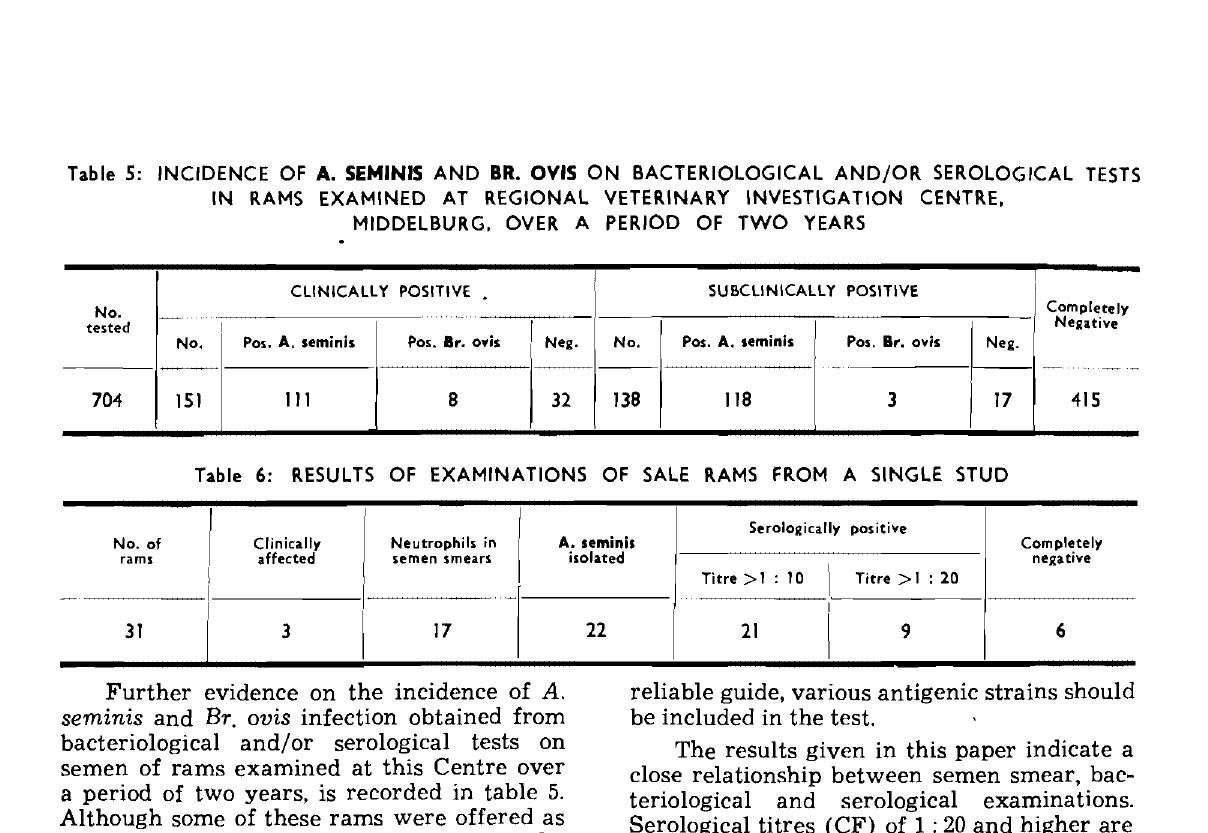
Table 5: INCIDENCE OF A. SEMINIS AND BR. OVIS ON BACTERIOLOGICAL AND/OR SEROLOGICAL TESTS IN RAMS EXAMINED AT REGIONAL VETERINARY INVESTIGATION CENTRE, MIDDELBURG, OVER A PERIOD OF TWO YEARS